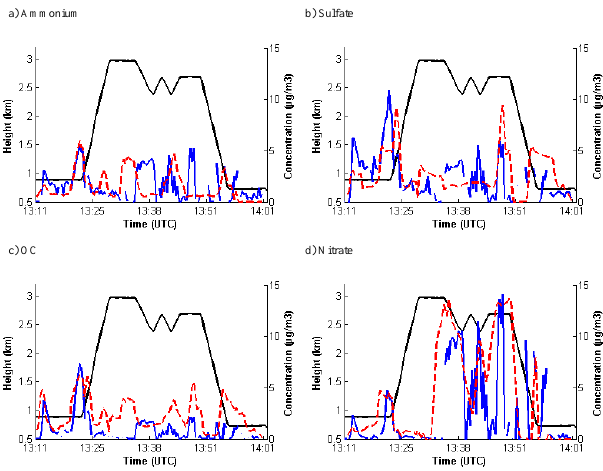
Figure 9. Evolution of (a) ammonium, (b) sulfate, (c) OC and (d) nitrate mass concentration (µgm − 3 ) obtained from AMS measure- ments (blue solid line) and simulated (red dashed line) over the Netherlands between (52.57 ◦ N, 6.34 ◦ E) and (51.88 ◦ N, 4.99 ◦ E) on 30 May 2008. The black line indicates the height of the